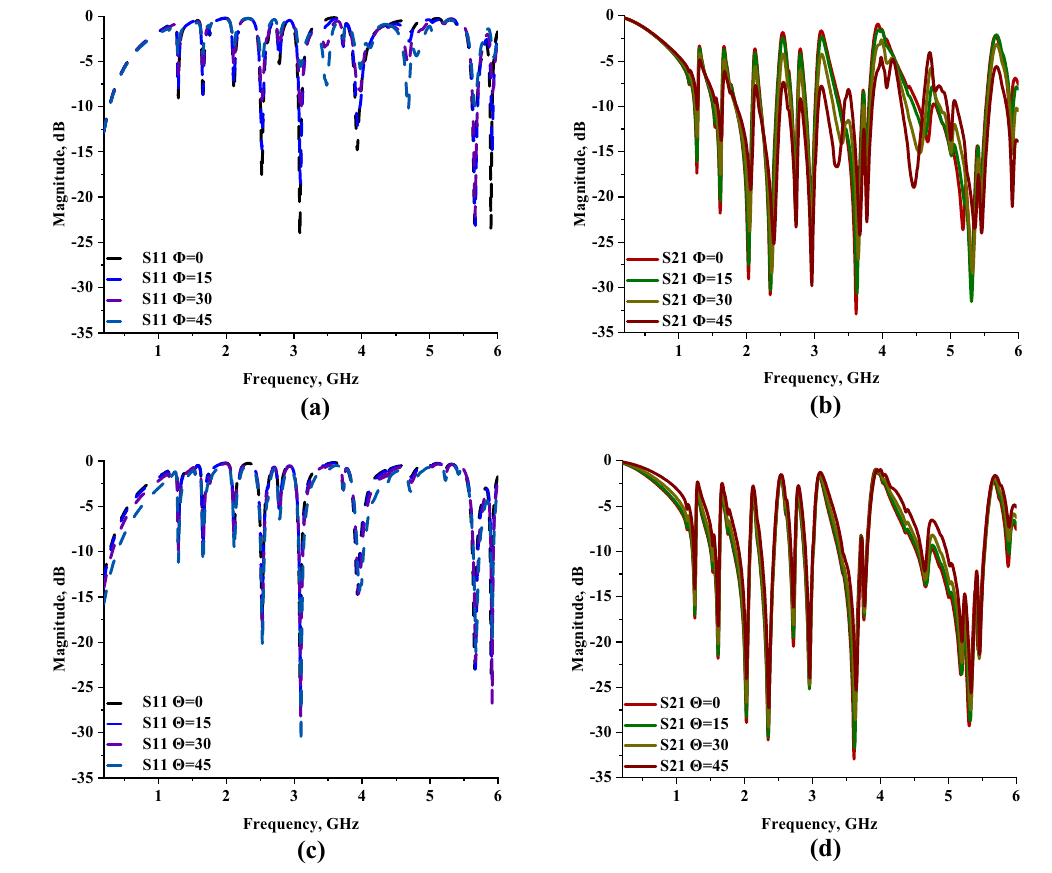
Figure 6. Phi and theta of 0° to 45°: (a) S11 Polarization, (b) S21 Polarization, (c) S11 Incident angle, (d) incident